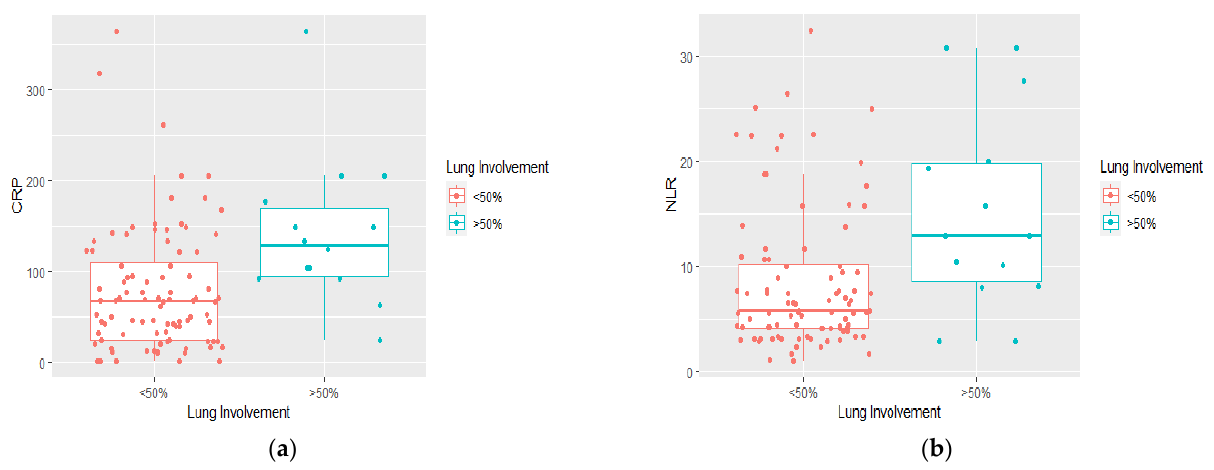
Figure 3. The difference in medians of inflammatory markers according to lung involvement on CT scan on admission: ( a ) C ‐ reactive protein (mg/dL); ( b ) neutrophil to lymphocyte ratio. The x ‐ axis represents the classification of lung involvement: <50% (non ‐ severe), >50% (severe). On the y ‐ axis the value of CRP and NLR, respectively.